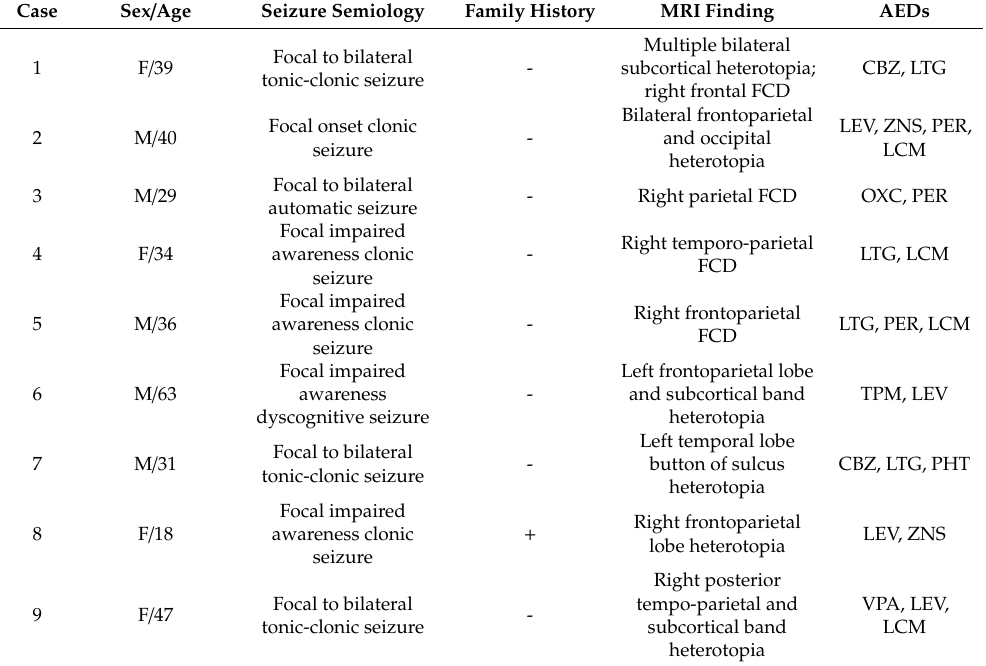
MRI: brain magnetic resonance imaging; FCD: focal cortical dysplasia; AED: antiepileptic drug; CBZ: carbamazepine; LTG: lamotrigine; VPA: valproic acid; LEV: levetiracetam; ZNS: zonisamide; PER: perampanel; LCM: lacosamide; RFM: rufinamide; OXC: oxcarbazepine; TPM: topiramate; PHT: